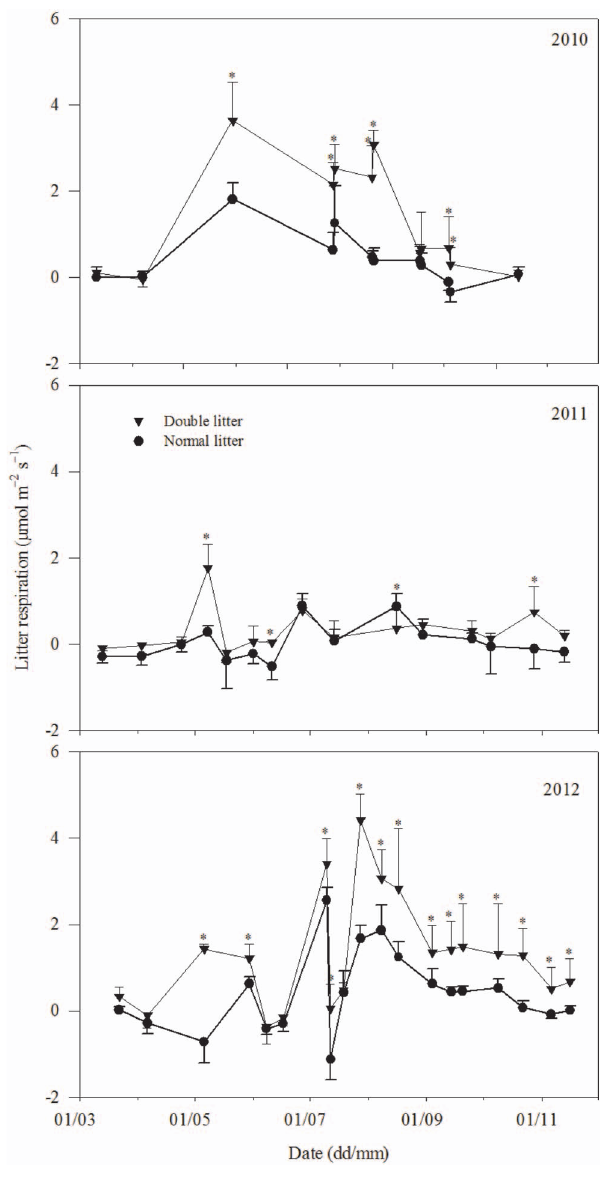
Figure 5. Variation in litter respiration ( m mol m 2 2 s 2 1 ) with normal and double litter treatments in 2010, 2011, and 2012, respectively. The asterisk indicates a significant difference at P ,